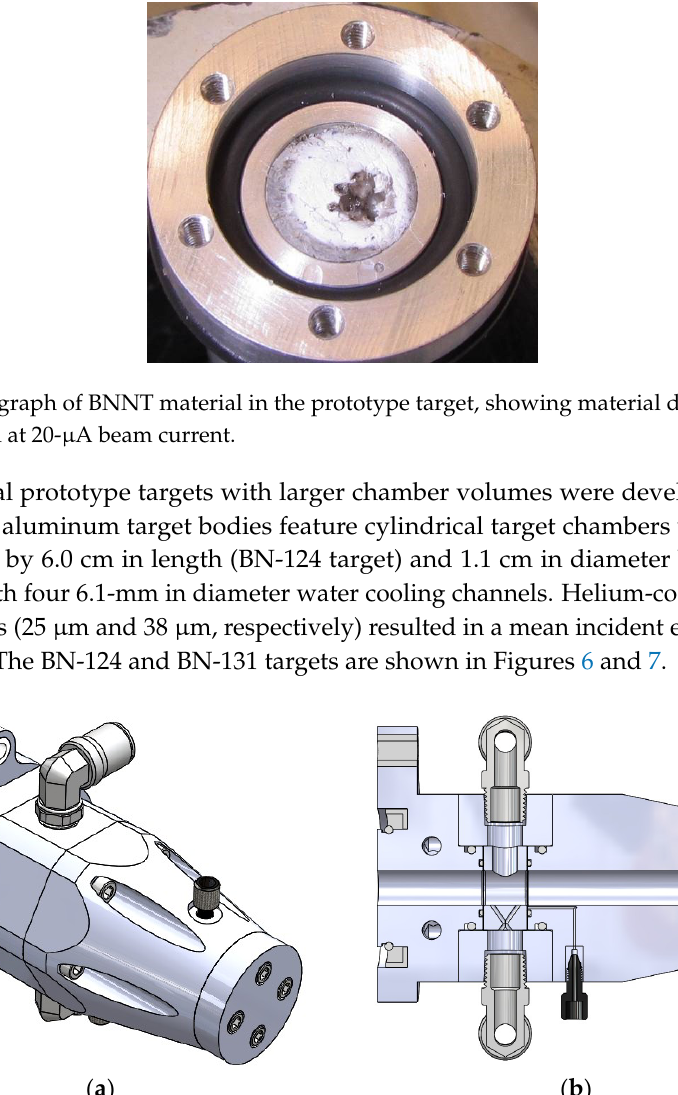
Figure 7. BN-131 target: ( a ) Isometric and ( b ) vertical mid-plane cross-section views.